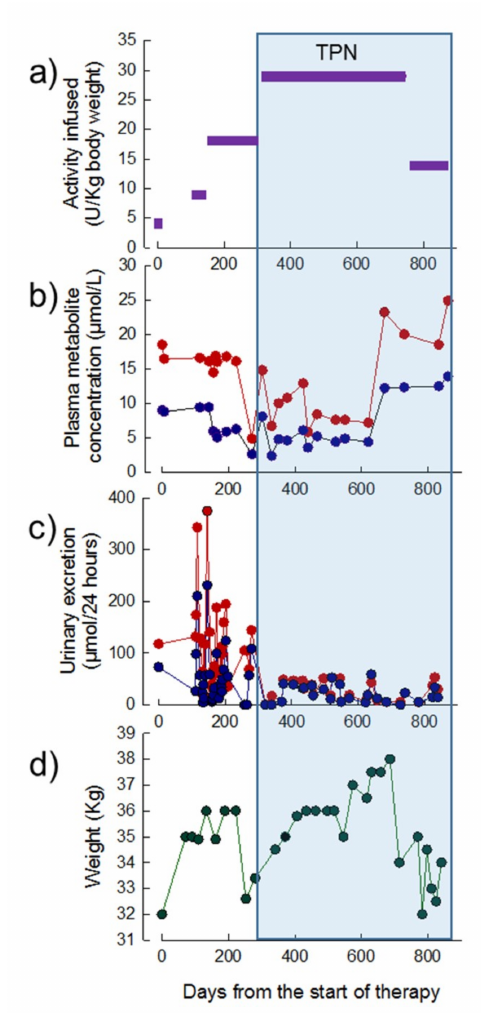
Figure 4. Dose of EE-TP administered, plasma concentrations of deoxyribonucleosides, urinary excretion of deoxyribonucleosides, and body weight in Patient 1 during 28 months of therapy with EE-TP. ( a ) The dose of encapsulated thymidine phosphorylase infused was determined using high performance liquid chromatography (HPLC). ( b ) Mid cycle plasma thymidine (blue data points) and deoxyuridine (red data points) concentrations were measured by Ultra-Performance Liquid Chromatography (UPLC). ( c ) Mid cycle urinary excretions of thymidine (blue data points) and deoxyuridine (red data points) were determined by measuring the concentration of metabolites in 24 h urine collections. ( d ) Patient body weight. The blue shaded area represents the timeframe in which TPN was